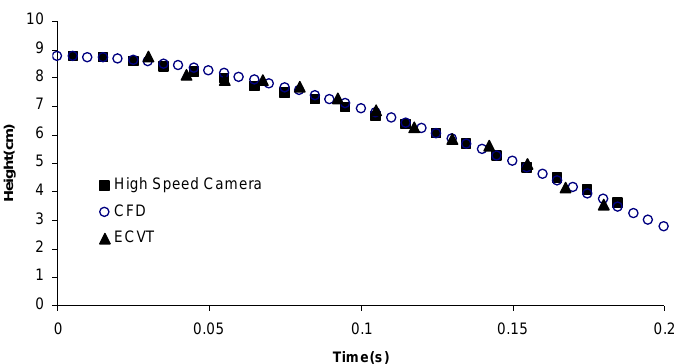
Figure 15. Comparisons of measurements using high speed camera, ECVT, and CFD for the relative position and time of a free falling ball in the Paratherm fluid.